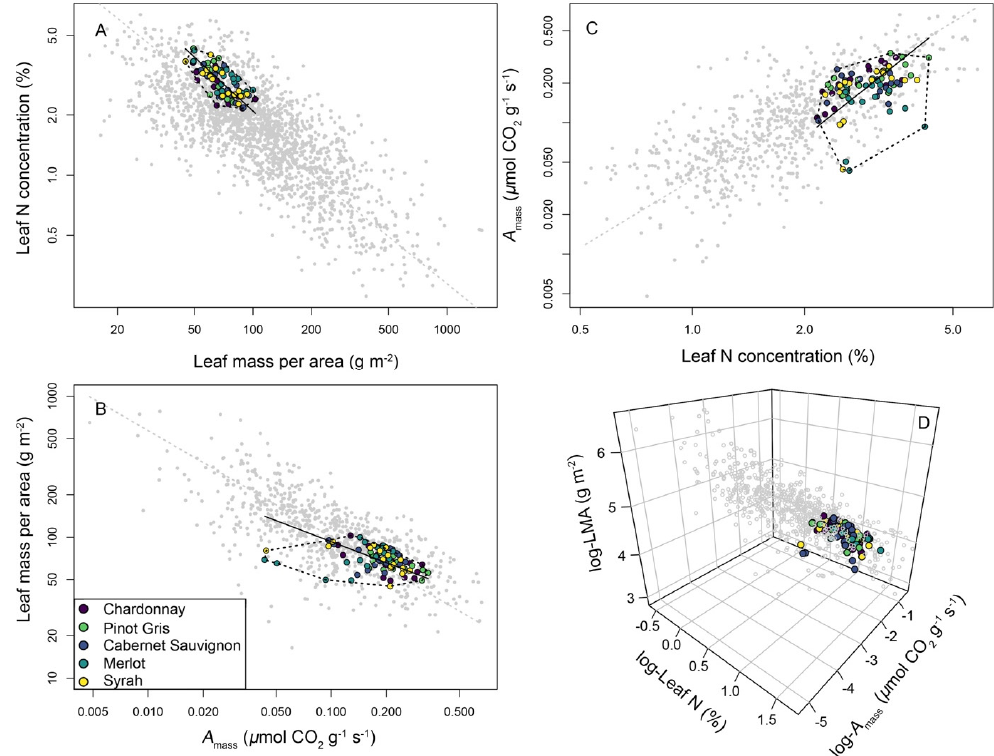
Figure 5. Leaf Economics Spectrum trait relationships in wine grapes. Presented here are bivari- ate relationships across three core LES traits including Amass, LMA, and leaf N concentrations (Panels A – C ), as well as a three-dimensional representation of the relationships across the same traits (Panel D ). Coloured points correspond to different grape varieties, which are not differentiated based on growth stage here to aid in visualization. Black solid trend lines correspond to the standardized major axis (SMA) regression model of a given bivariate trait relationship across wine grapes (where SMA model p < 0.05 and r 2 ≥ 0.189 in all cases) and dashed black trend lines in (Panels A – C ) represent convex hull models that encapsulate the two-dimensional trait space occupied by wine grape leaves. Additionally, data and SMA models for the same LES trait relationships observed among wild plants in the GLOPNET dataset are shown in all panels (grey dashed trend lines and points). SMA models were fit to the ‘Wine grape variety’ dataset, and wild plants were derived from the GLOPNET dataset (Wright et al., 2004). Full model diagnostics for each SMA model in (Panels A – C ) are presented in Table S4. Trait abbreviations are as follows: A mass : light saturated maximum photosynthetic rate on a per-unit leaf mass basis; LMA: leaf mass per unit